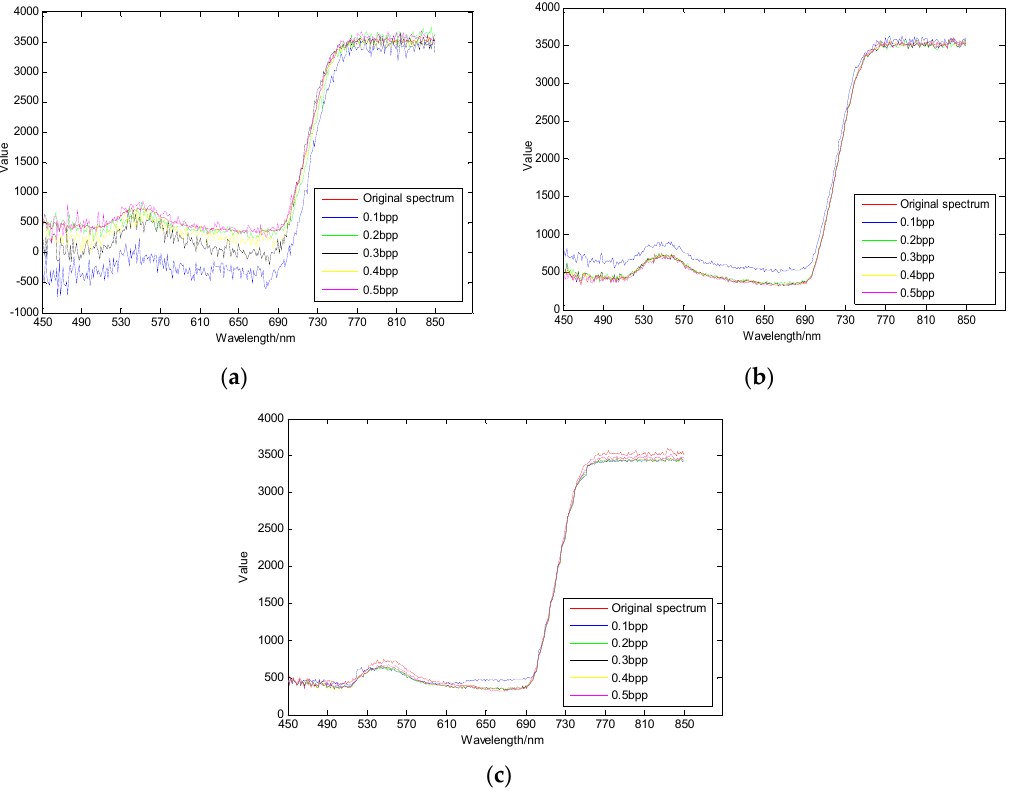
Figure 11. Comparison of reconstructed spectral curves of ROI2. ( a ) OMP; ( b ) GPSR; ( c ) AGDCS.